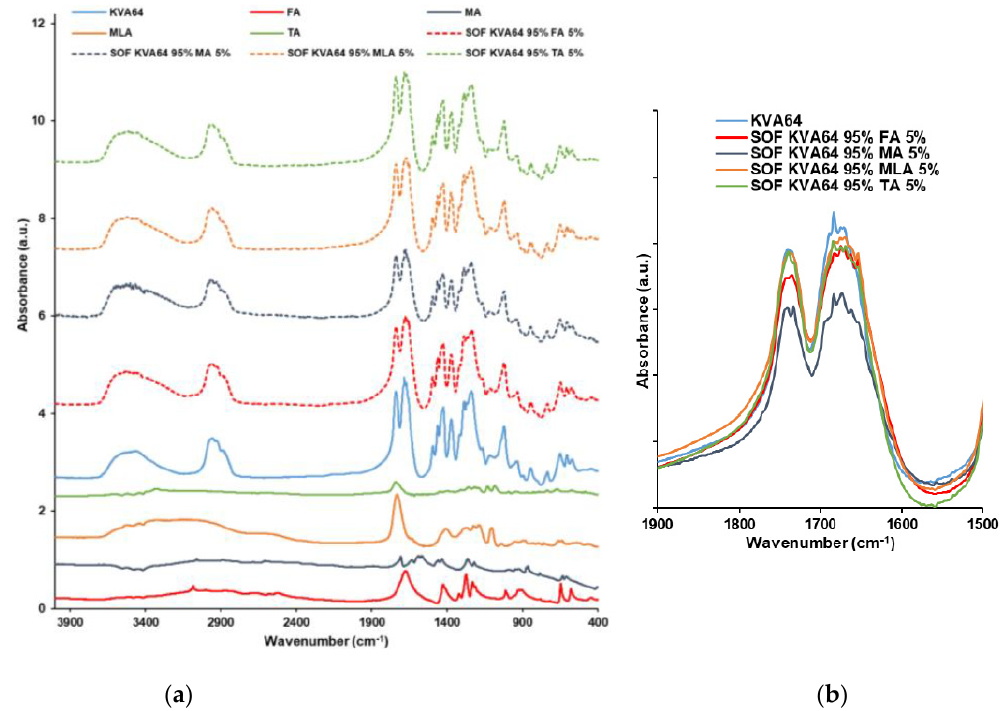
Figure 4. FTIR spectrums of KVA64, FA, MA, MLA, TA and printed SOFs: ( a ) from 400 to 4000 cm − 1 , ( b ) from 1500 to 1900 cm − 1 .